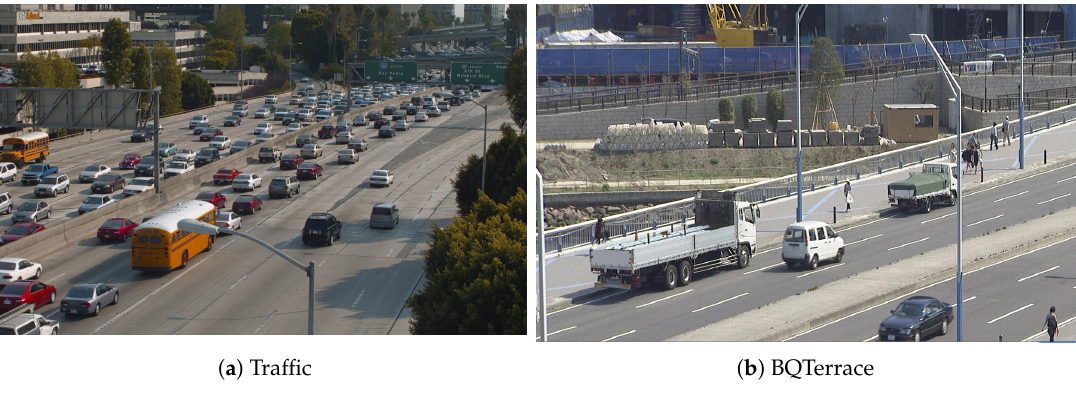
Figure 9. Traffic scenario.